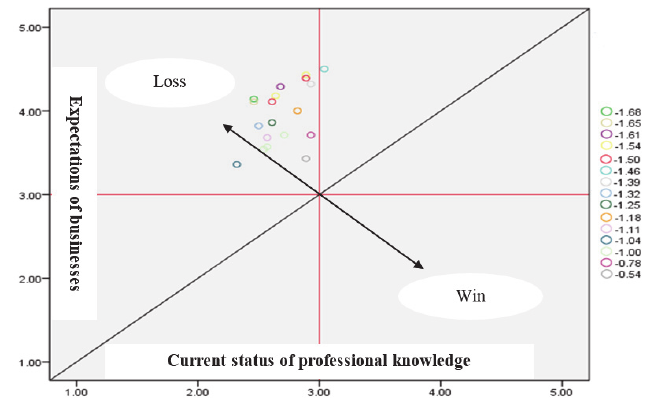
Fig. 3. Business satisfaction on professional